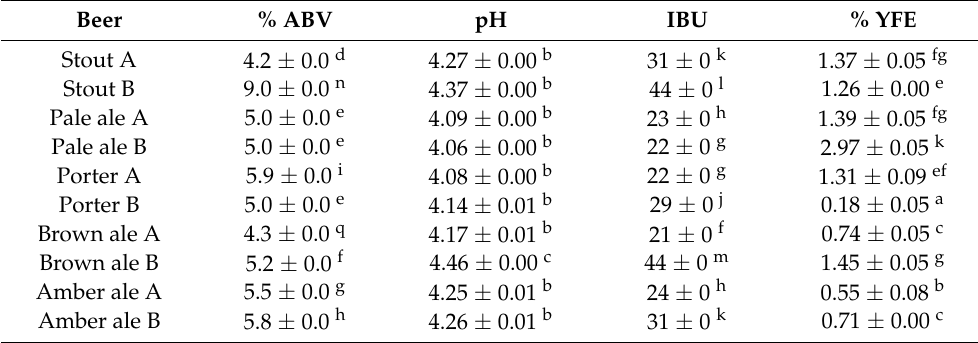
Table 2. Values of main physicochemical parameters of 20 commercially